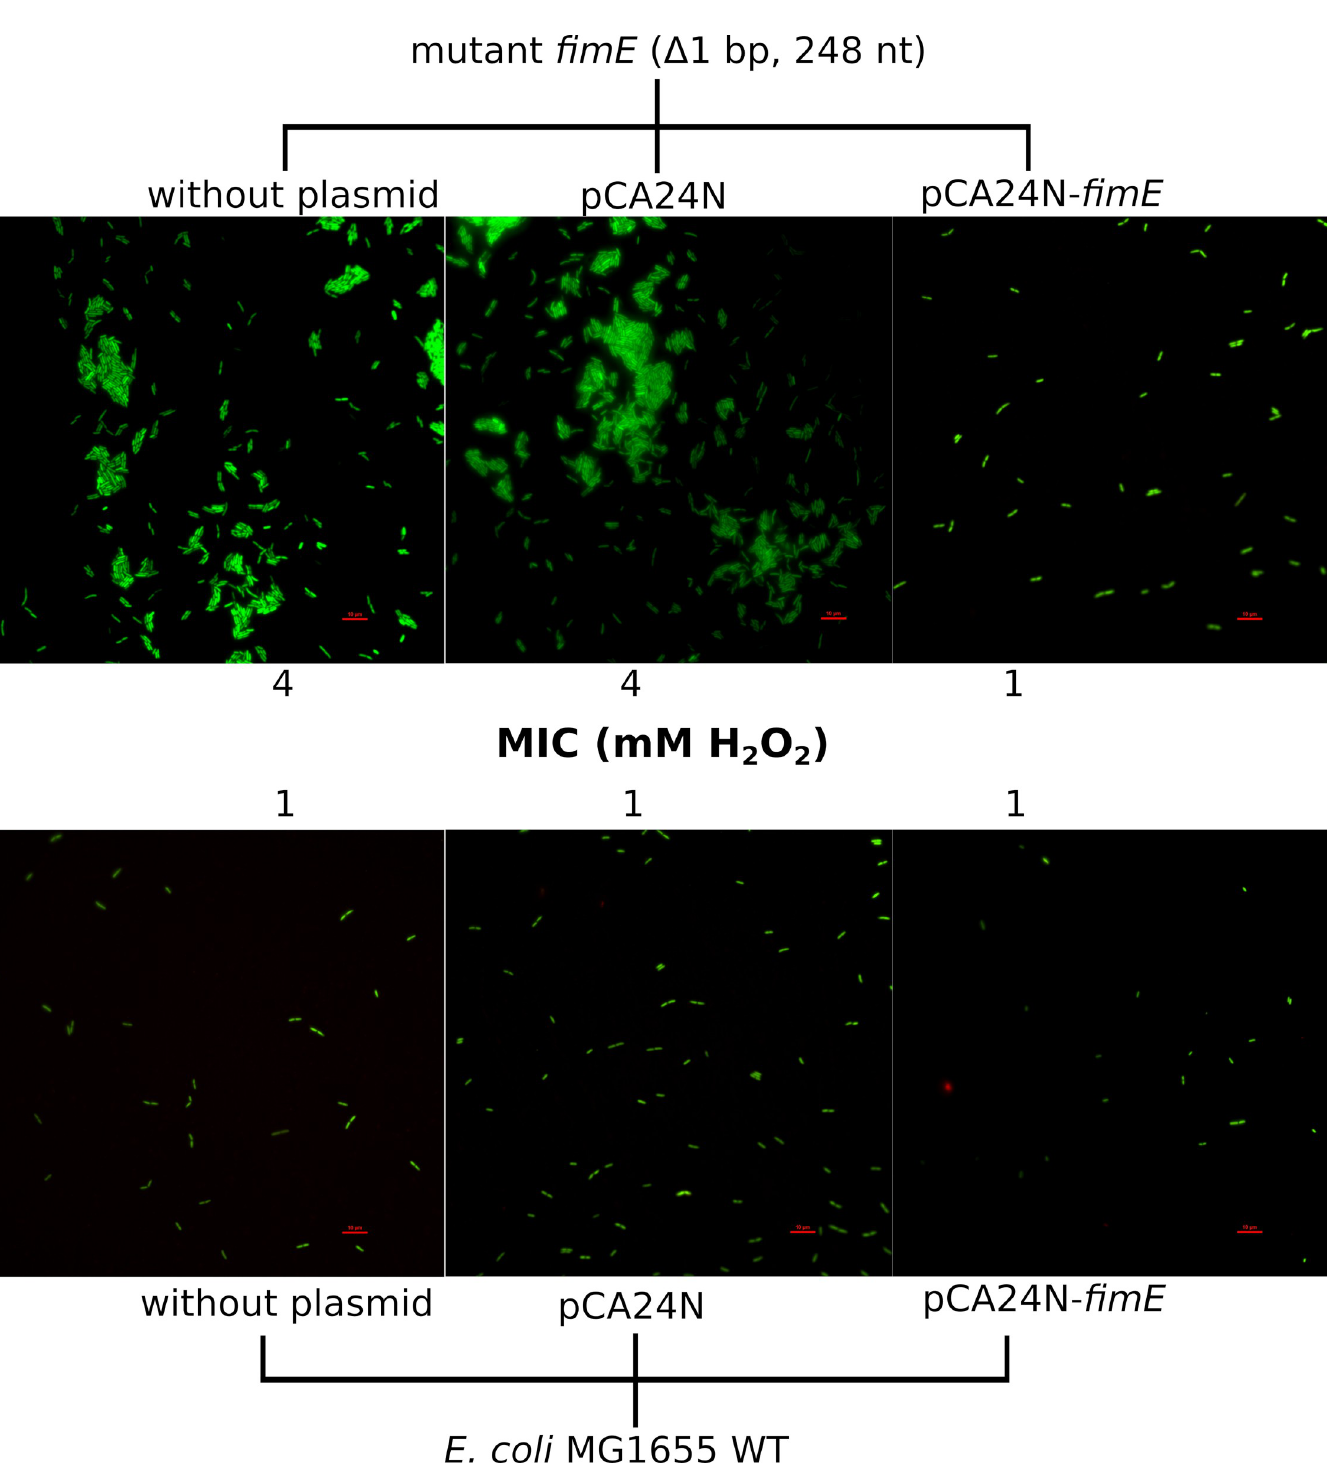
PLOS Genetics | https://doi.org/10.1371/journal.pgen.1008649 March 12,